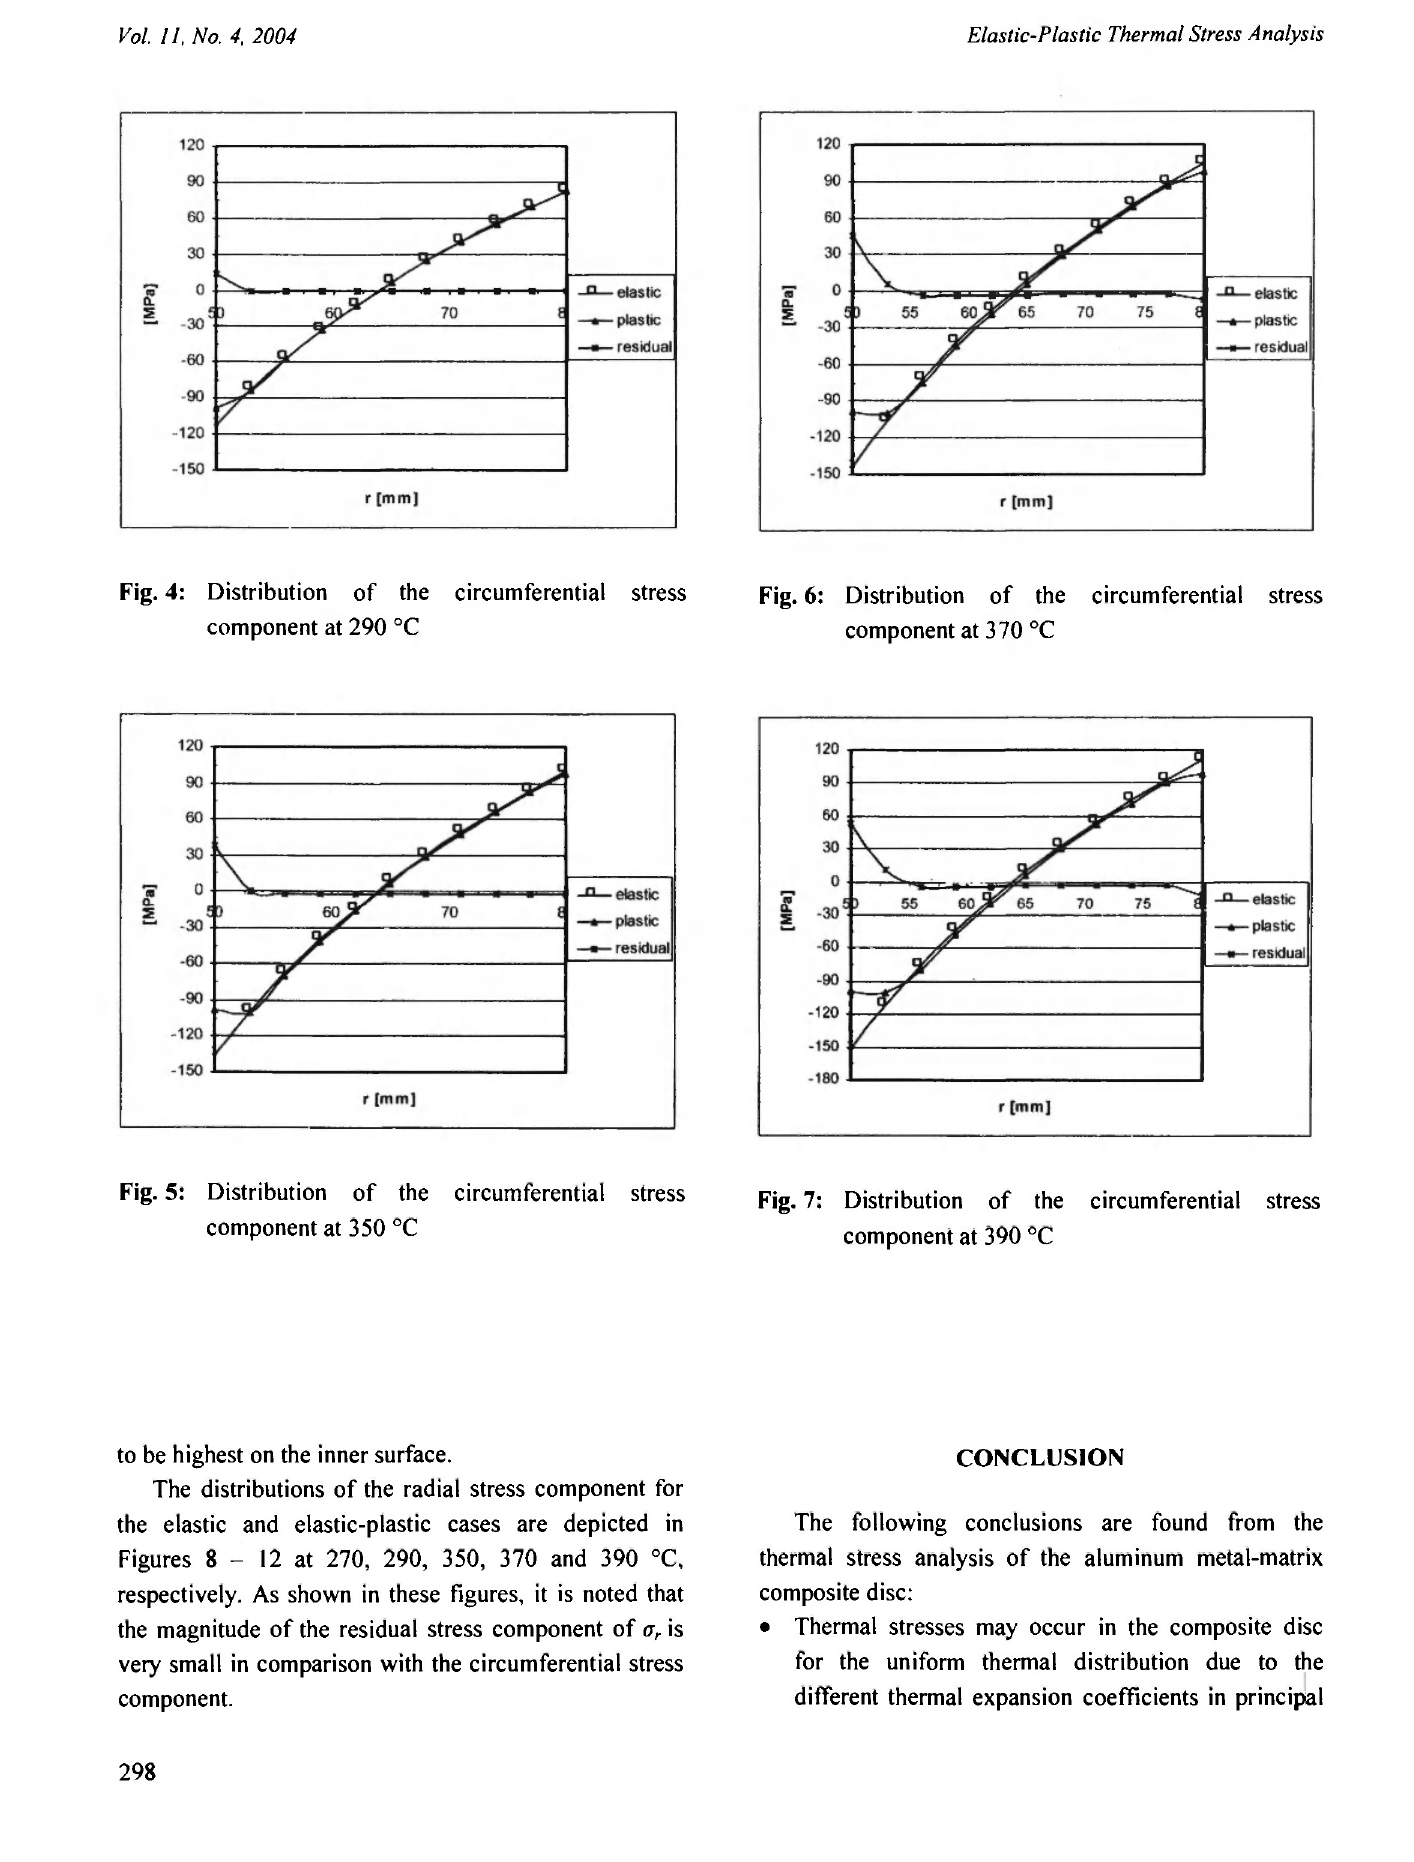
Fig. 4: Distribution of the circumferential stress component at 290 °C